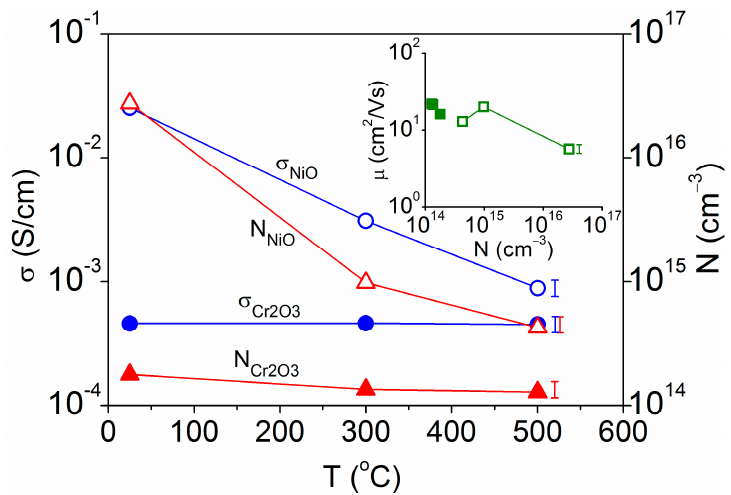
Figure 6. Electrical conductivity and carrier concentration for the NiO and Cr 2 O 3 films as a function of the heating temperature. The inset shows carrier mobility versus concentration for the various samples. The error bars are within 5 − 15% of the mean value. The maximum (15%) is represented on the right, being in the same order as the printed points.